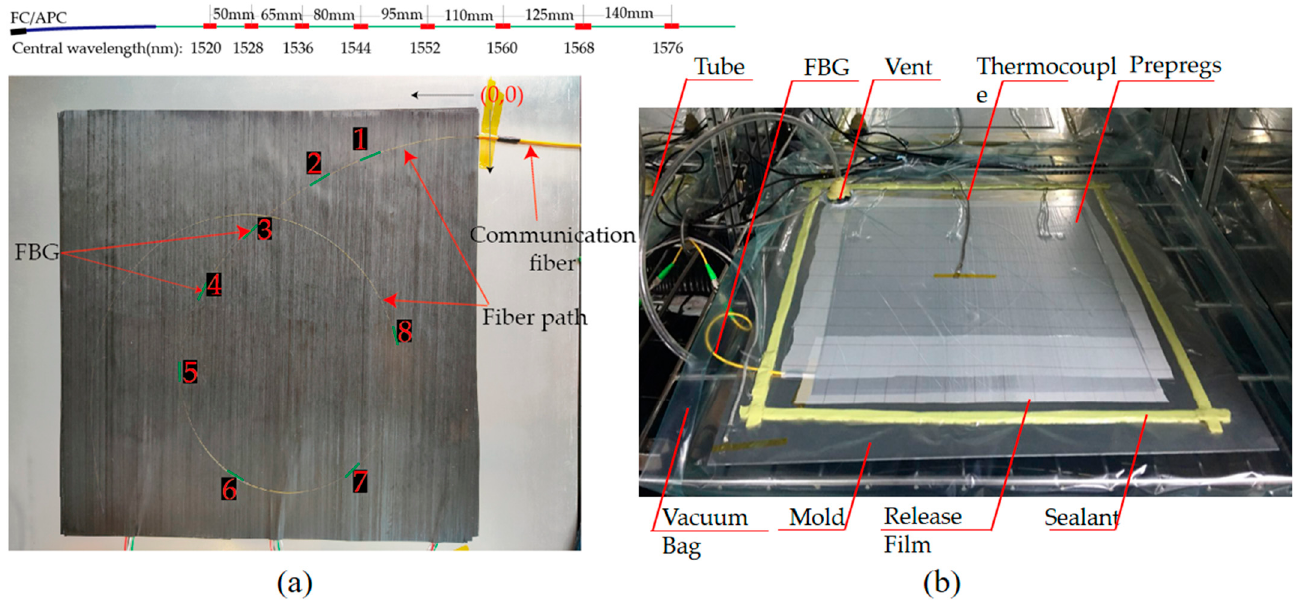
Figure 8. ( a ) Specifications and experimental layout of FBG sensors; ( b ) the scene picture of the experiment for the manufacturing process.